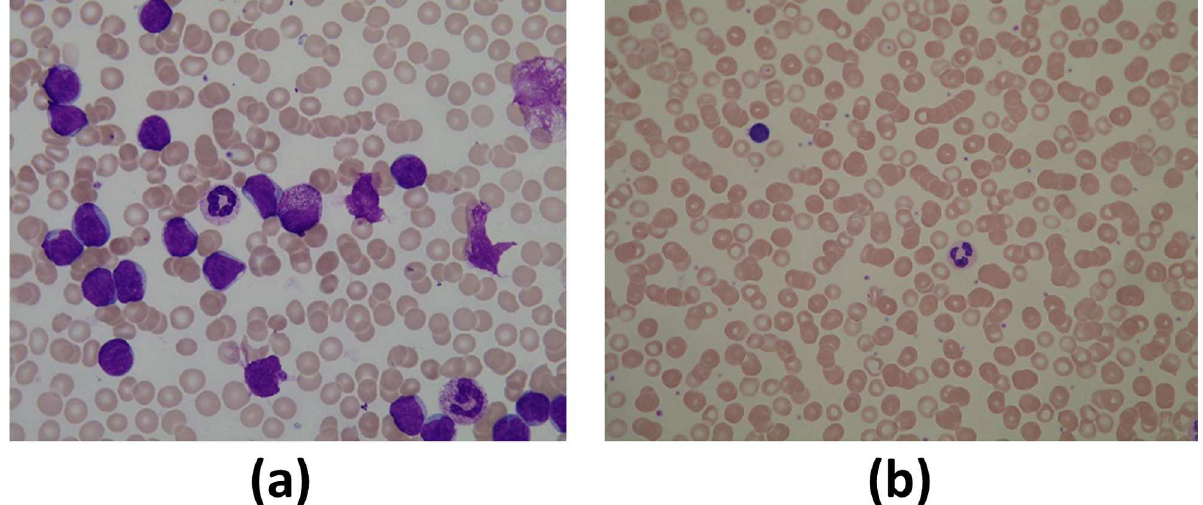
Fig 1. Blood smear images captured with different cameras and under different staining, scale, and illumination conditions. The image (a) is acquired with a magnification larger than the magnification of the image (b); hence the WBCs shown in image (a) look bigger than the WBCs of the image (b). The image (a) is brighter than the image (b), notice that the hue of the WBCs in both images is similar, but the hue of the background is different between the images (a) and (b). The size of image (a) and image (b) is 1368 × 1712 pixels and 1944 × 2592 pixels, respectively.